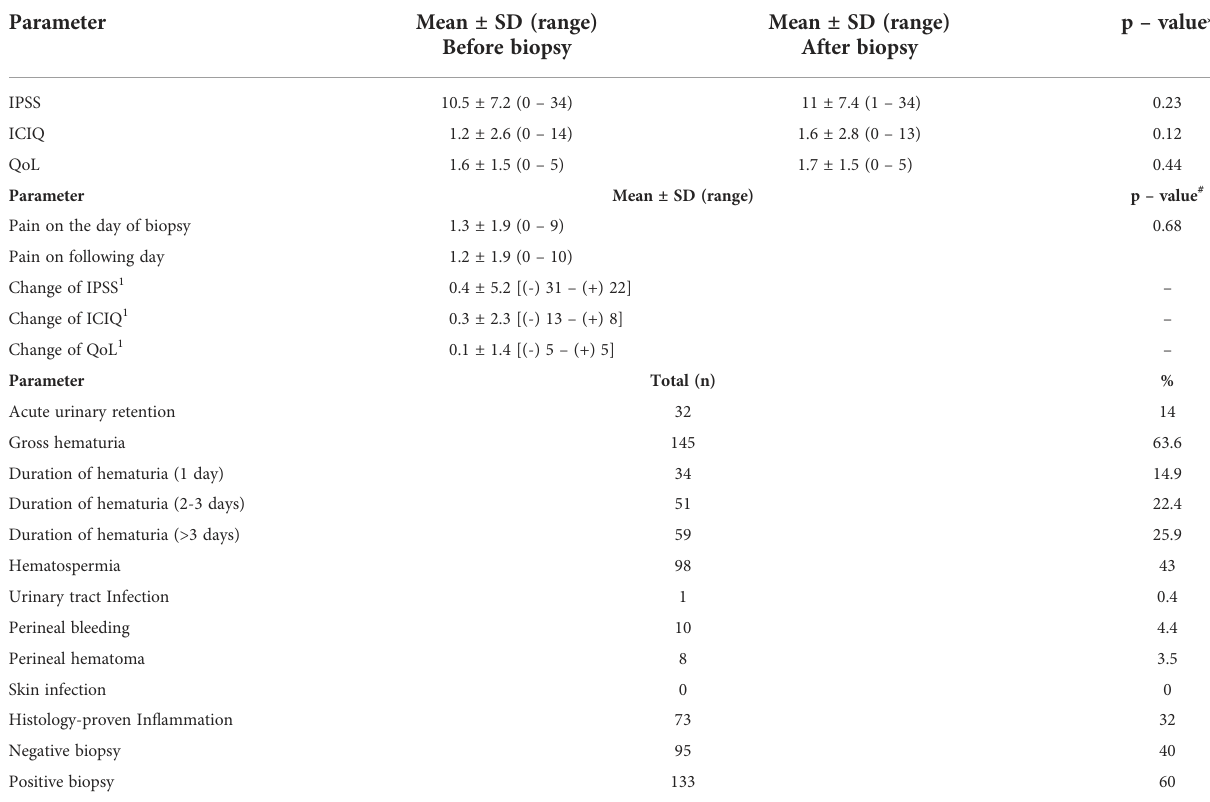
TABLE 2 Functional outcomes and side